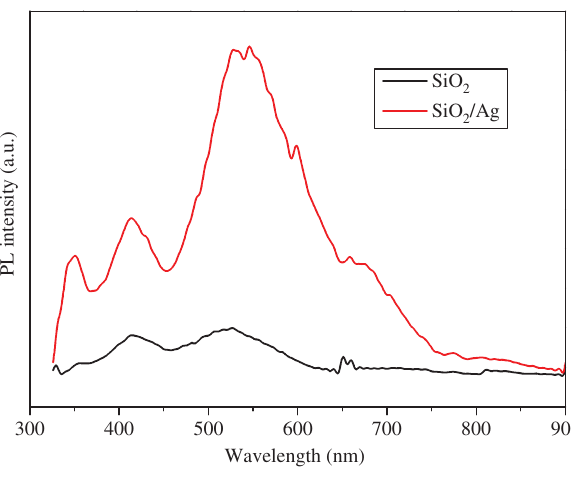
Figure 5: Photoluminescence spectra of pure silica powder and SiO /Ag composite 2